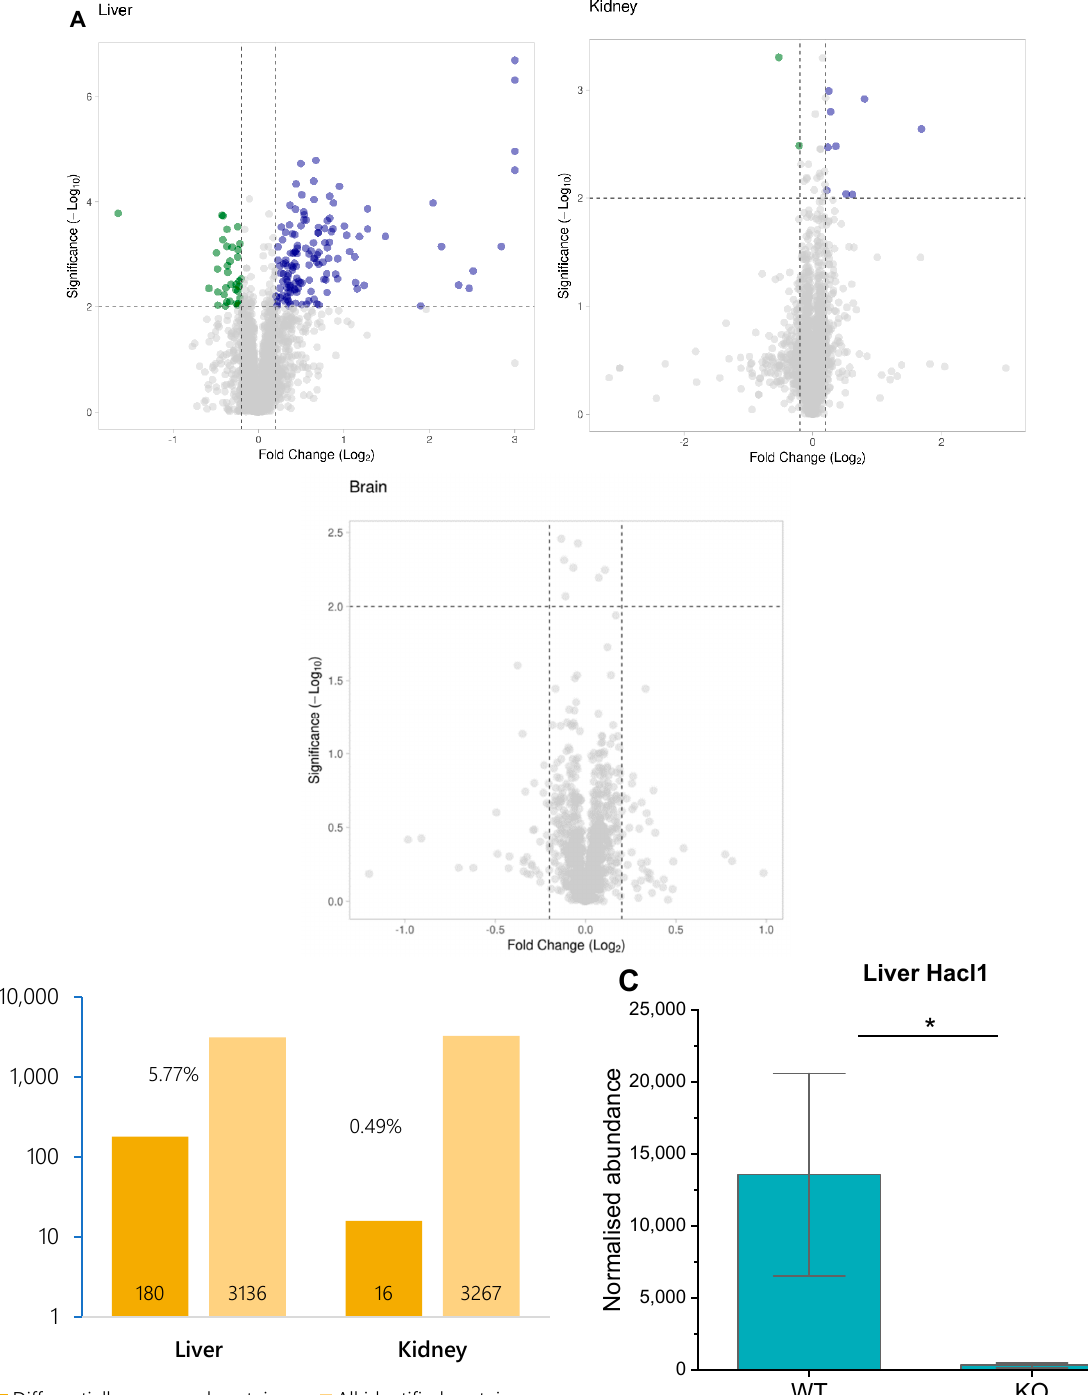
Figure 3. Proteomic analysis of Hacl1 − / − mouse tissue. ( A ) Scatter plot of proteins identified and their fold change in Hacl1 − / − liver, kidney, and brain tissue compared to wild-type. Proteins with 1.5-fold change ( p < 0.01) were chosen as significantly differentially regulated. ( B ) Percentage of differentially expressed proteins in Hacl1 − / − liver and kidney. ( C ) Hacl1 peptide abundance in mouse liver (* indicates p <